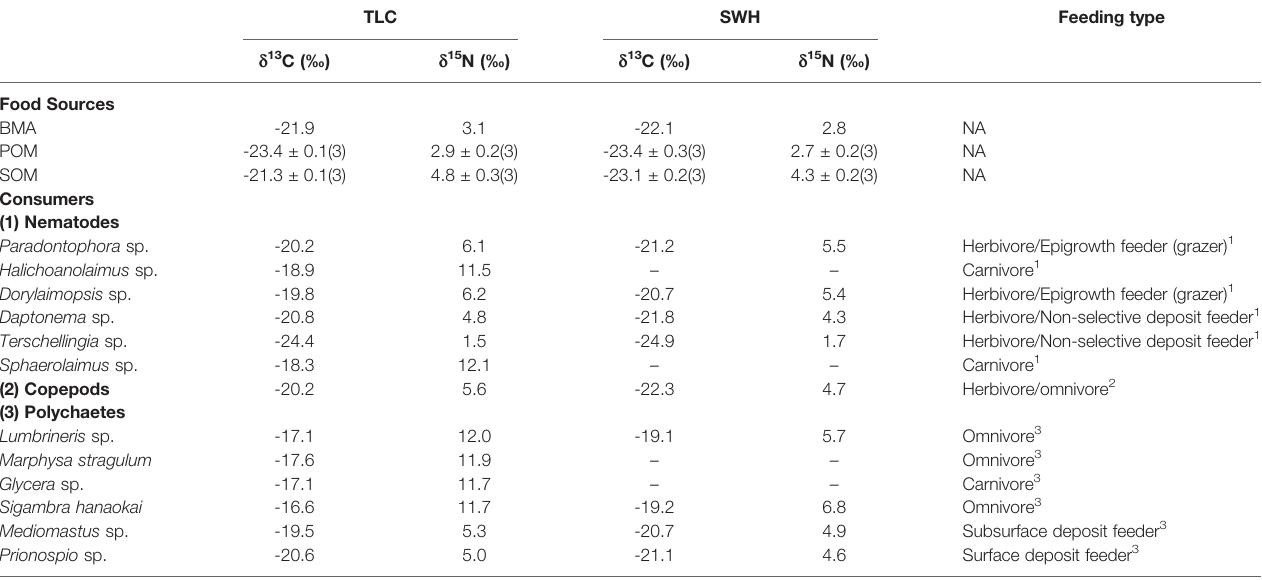
TABLE 1 | Stable isotope composition of food sources and consumers in subtidal sediments at the relatively unpolluted site TLC and organically enriched site SWH in subtropical Hong Kong. TLC